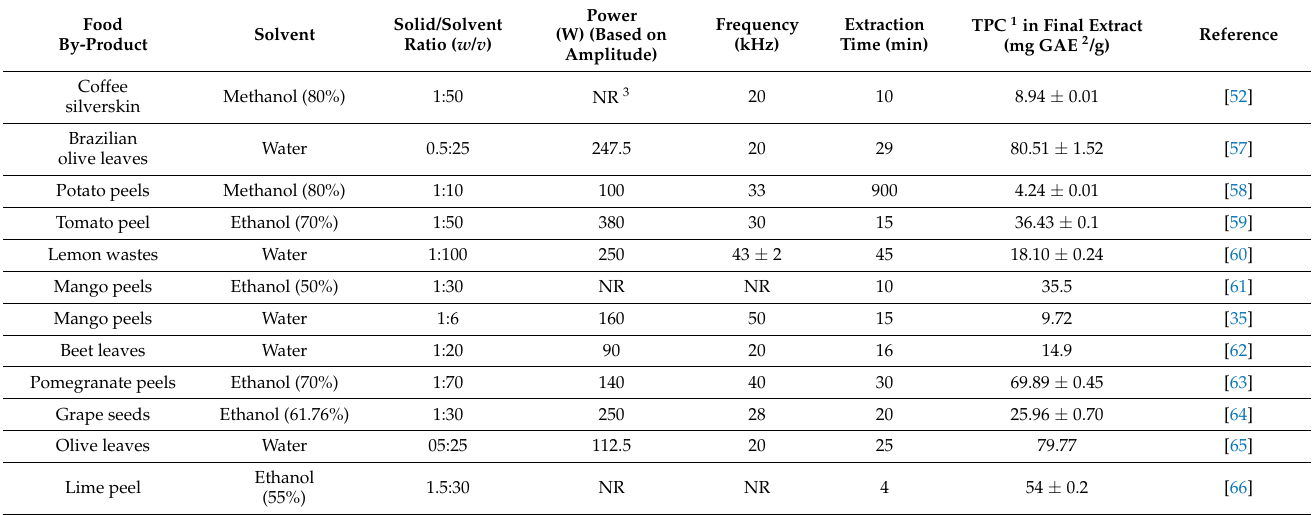
Table 1. Recovery of polyphenols from food by-products using